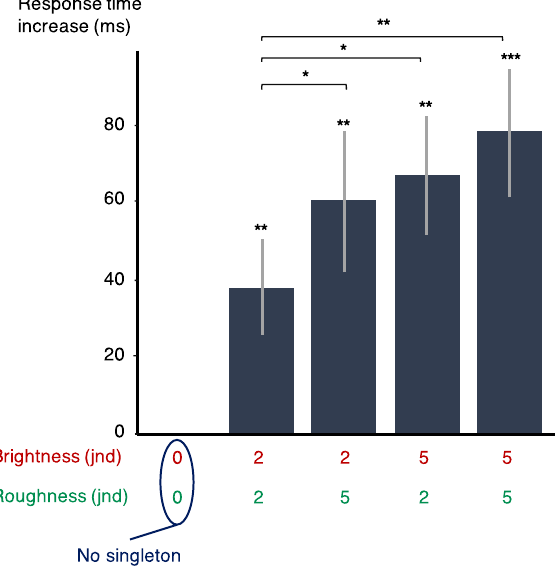
Figure 5. Increase in response time (ms) with singleton SC and modulation depth (experiment 5). Error bars represent the standard errors across participants in each condition compared to the no-singleton condition. Significances between conditions are displayed on the horizontal braces. *: p < .05, **: p < .01, ***: p <